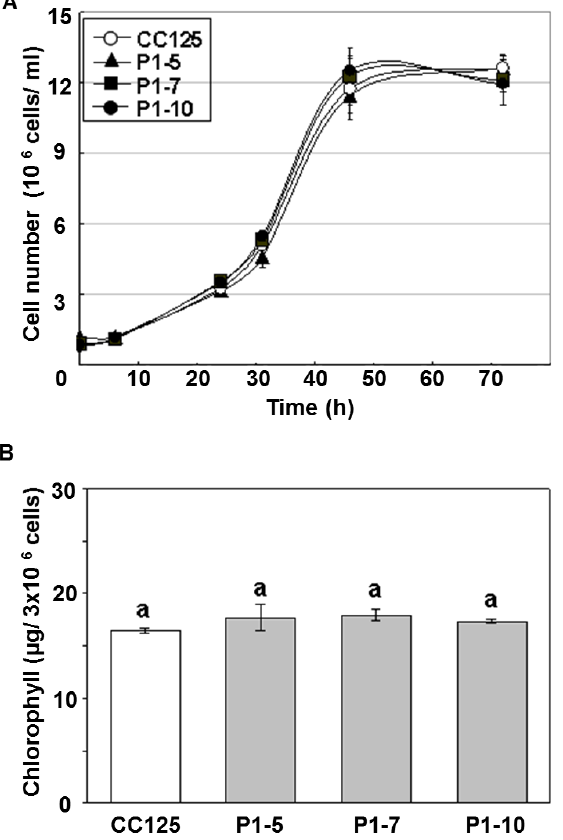
Figure 2. Growth curves and chlorophyll contents of transgenic Chlamydomonas overexpressing PETF under normal growth conditions. ( A ) The growth curves of non-transgenic (CC125) and PETF -transgenic lines (P1-5, P1-7, and P1-10) under normal growth conditions; ( B ) The chlorophyll contents of all algal lines. Error bars indicate the standard deviation of the mean for five repeats of cell suspensions, and letters on the columns indicate significant differences based on Duncan’s multiple range test ( p <